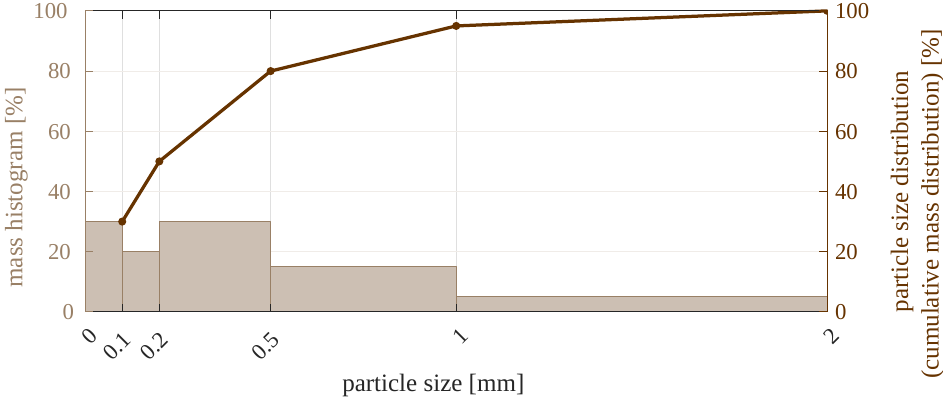
Figure 2. Dry samples of all individual size fractions of copper ore used in the experiments. From left to right: particles of size 0–0.1 mm; 0.1–0.2 mm; 0.2–0.5 mm; 0.5–1 mm; 1–2 mm. Figure 3. Composition of the mixed-size material used in the